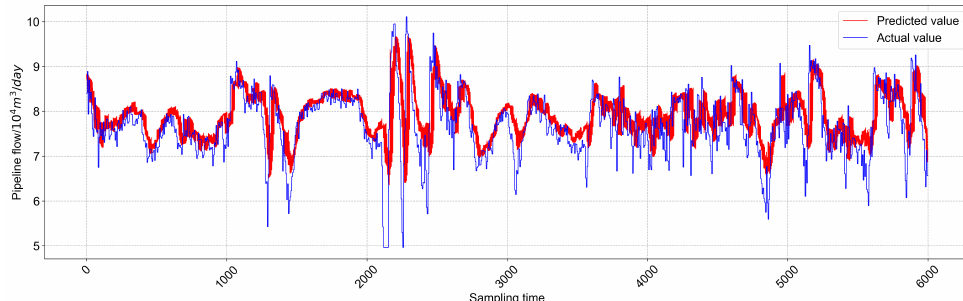
Figure 8. Prediction results of the NG pipeline flow from the LSTM.